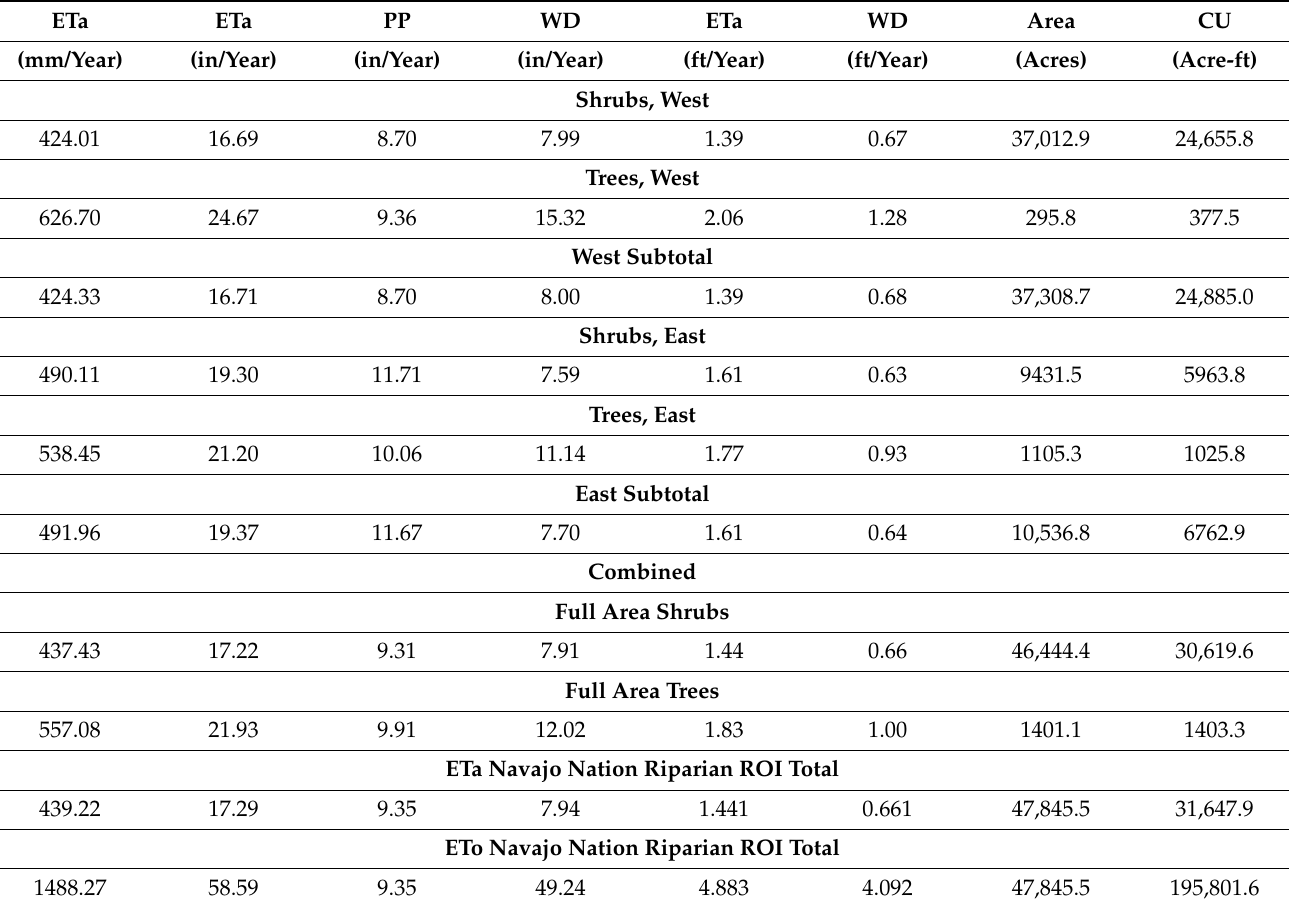
Table 6. Final water metric results for the riparian ROI showing the rasterized ‘conservative’ estimate of the mean data from 2014 to 2020 using gridded Daymet weather data (1 km) and Landsat (30-m) to derive ETa (mm, in, ft), PP (in), WD (in, ft) and ETo (mm, in, ft) (last row); the CU (acre-ft, last column) is calculated by ground area for shrubs, trees, and total riparian